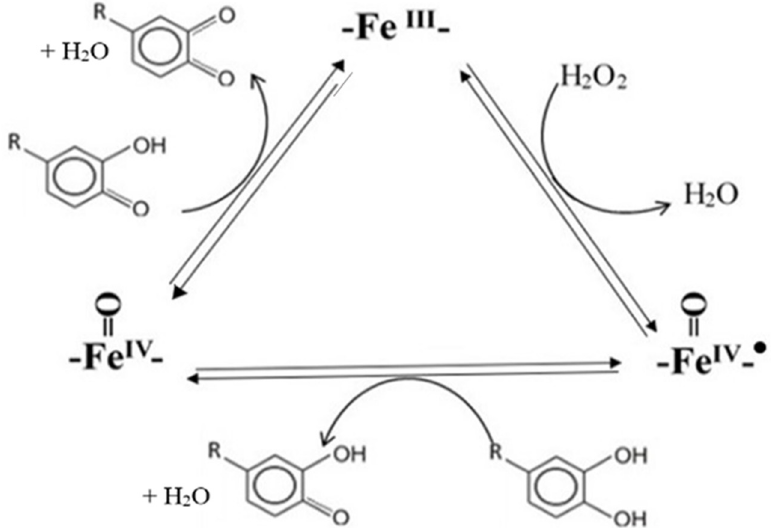
Figure 4. The detection principle of the Prussian blue-peroxidase based biosensor towards caffeic acid in the presence of hydrogen peroxide. R is -CH=CH-COOH.